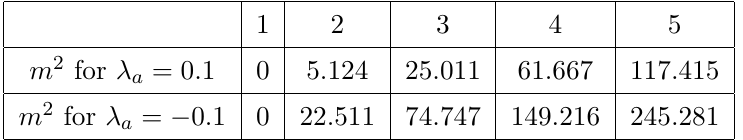
Table 1 . Mass spectrum for d = 3 .